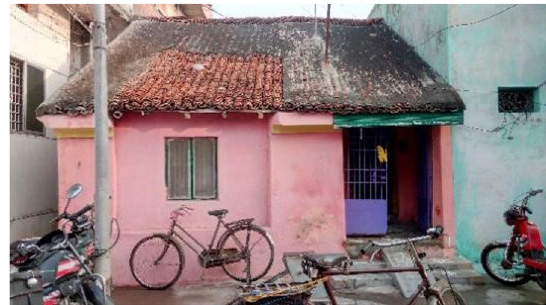
Fig. 7 Vehicles parked on the streets (Source: the